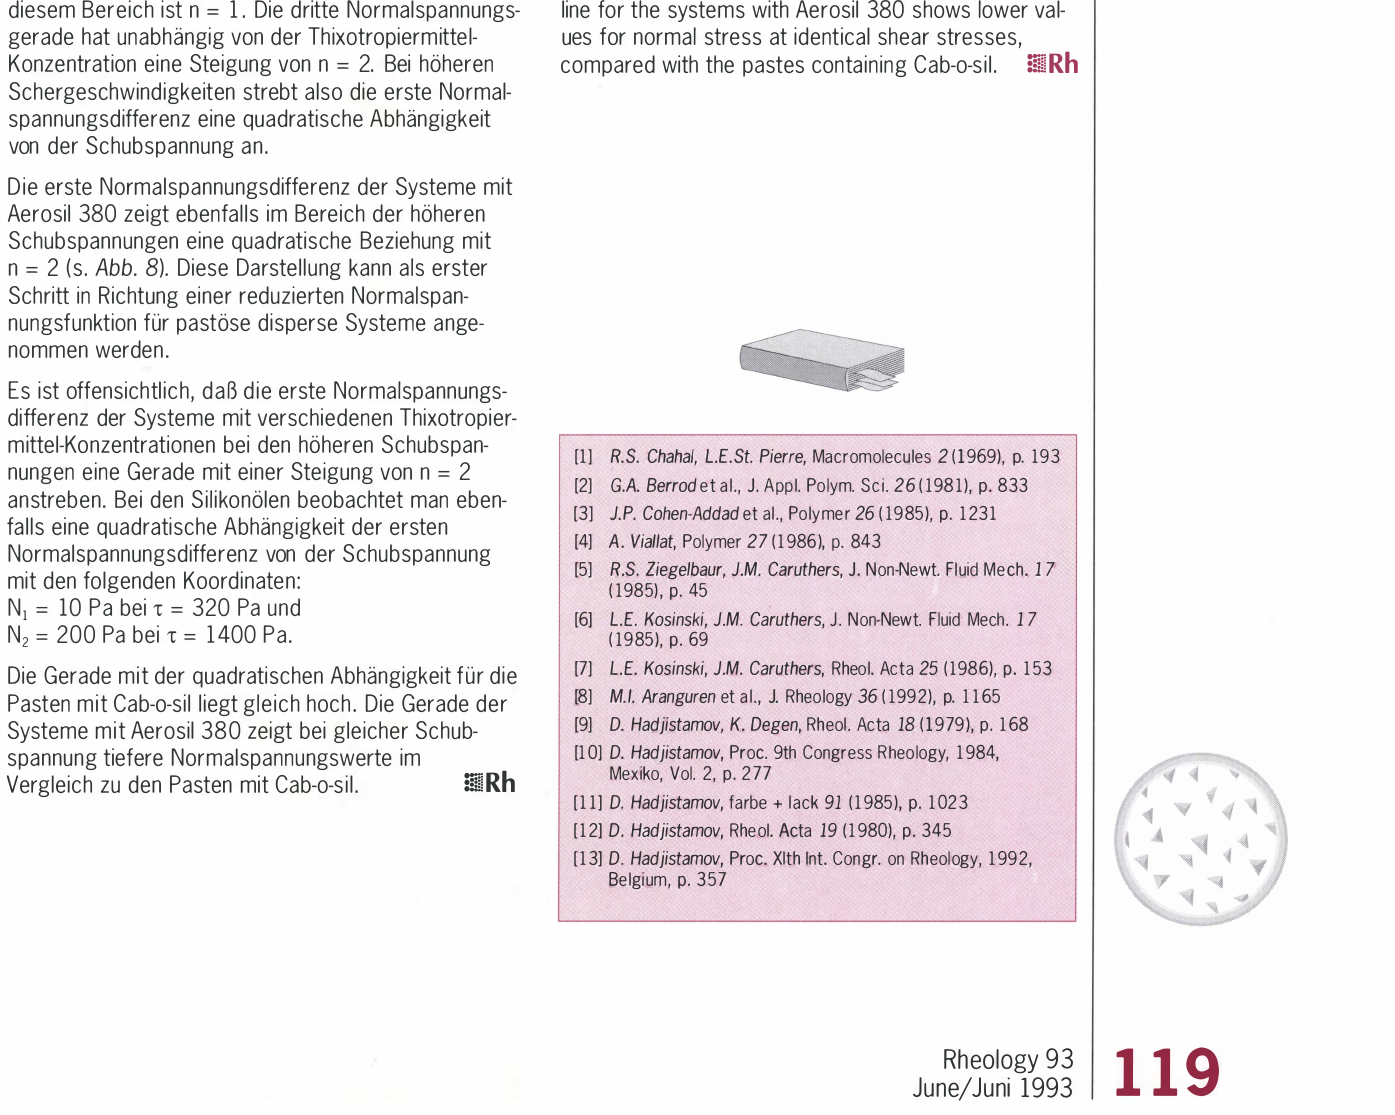
The first normal stress difference of the systems con­ taining Aerosil 380 likewise shows a square relation­ ship at higher shear stresses, the slope being 2 (see Fig. 8). This description can be assumed to be as a first step towards a reduced normal stress function for paste-like, disperse systems. It is evident that the first normal stress difference of systems with different thixotropic agent concentra­ tions tend, at higher shear stresses, towards a straight line with a slope of 2. In the case of silicone fluids one also observes a square dependence of the first normal stress difference on shear stress, with the following coordinates: N1 10 Pa att 320 Pa and = = N1 200 Pa at t 1400 Pa. = = The straight line with the square dependence for the pastes with Cab-o-sil is somewhat lower. The straight line for the systems with Aerosil 380 shows lower val­ ues for normal stress at identical shear stresses, compared with the pastes containing Cab-o-sil.